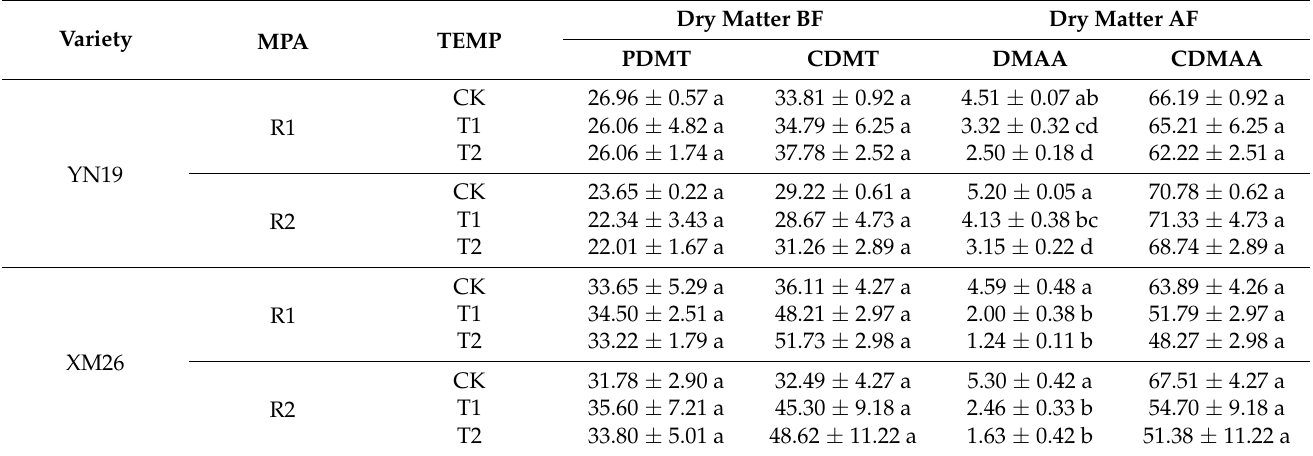
Table 4. Effects of OPA on wheat redistribution under low-temperature stress during the anther differentiation